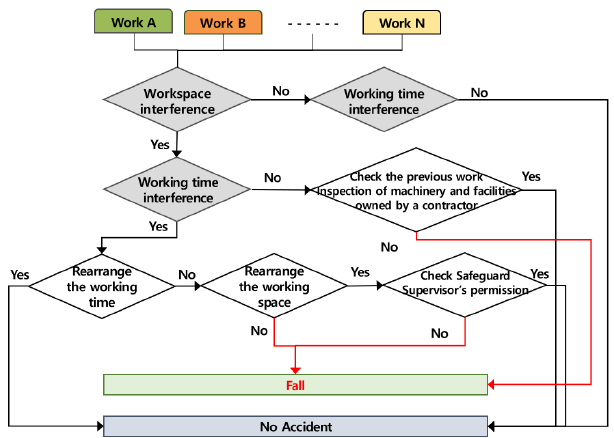
Figure 7. Mechanism of fall accident by multiple processes in the workplace (AMMP model for fall).